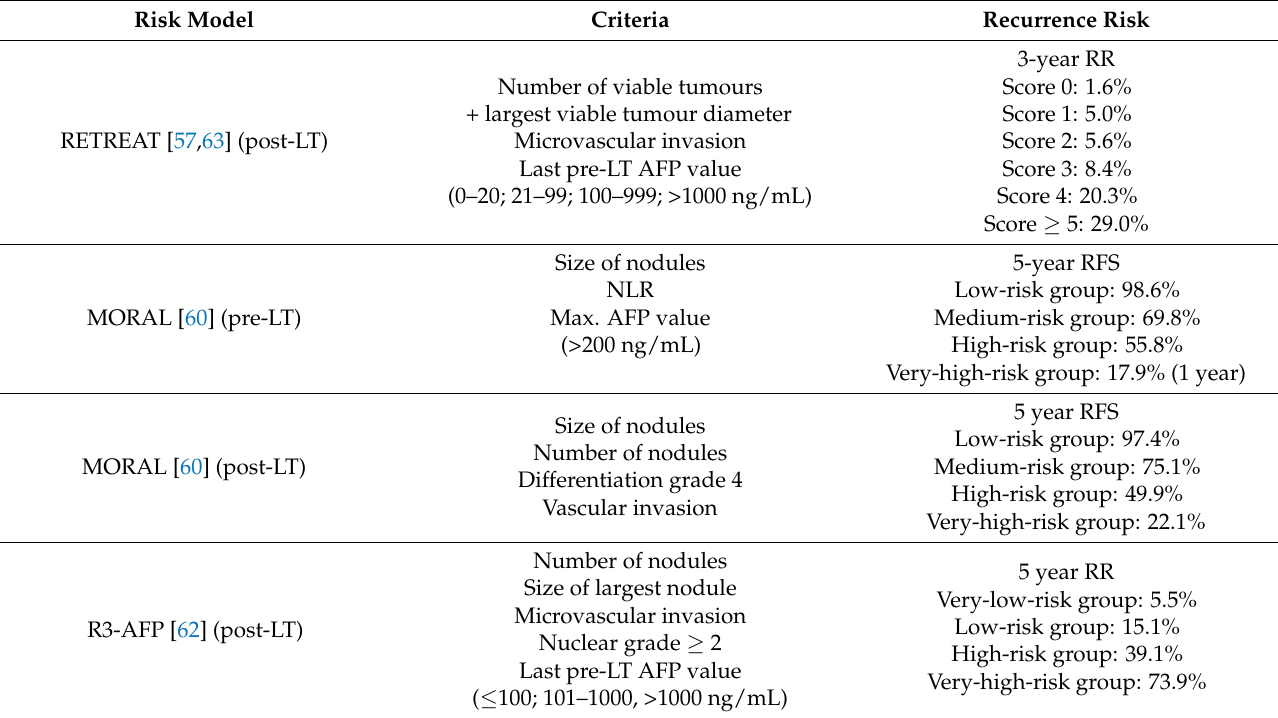
Table 2. Post-transplant recurrence-risk